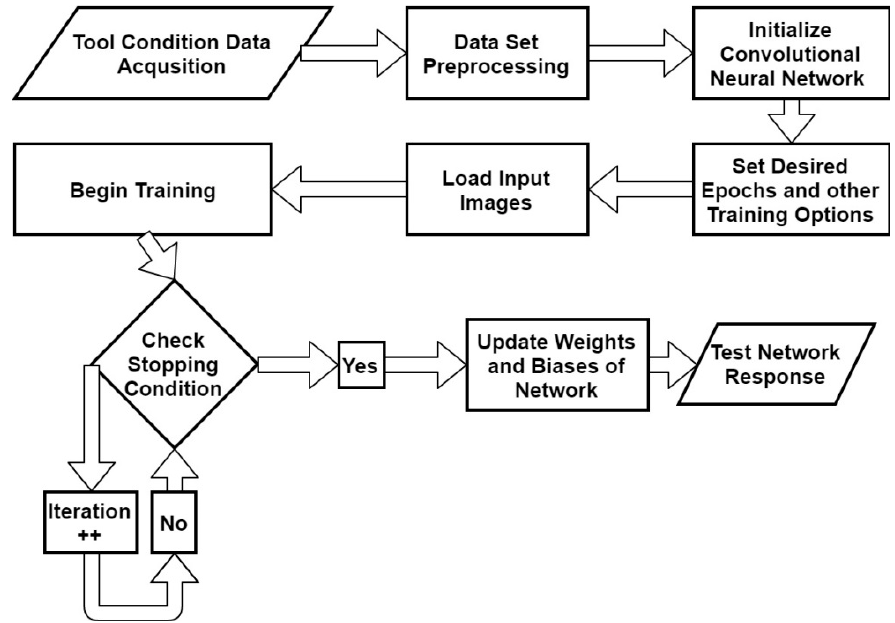
Figure 1. Flow chart of the proposed technique.